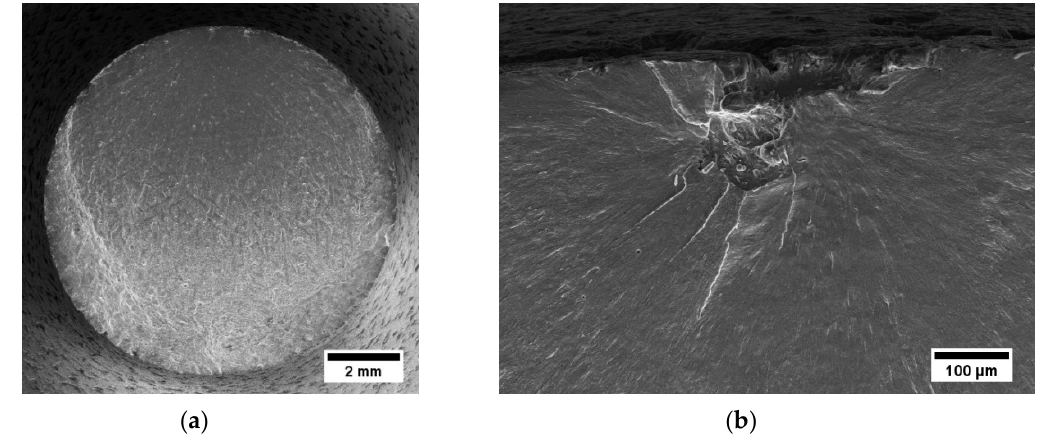
Figure 12. Fracture surface of a VF sample failed at the maximum stress of 95 MPa; ( a ) general view; ( b ) main crack nucleation site.